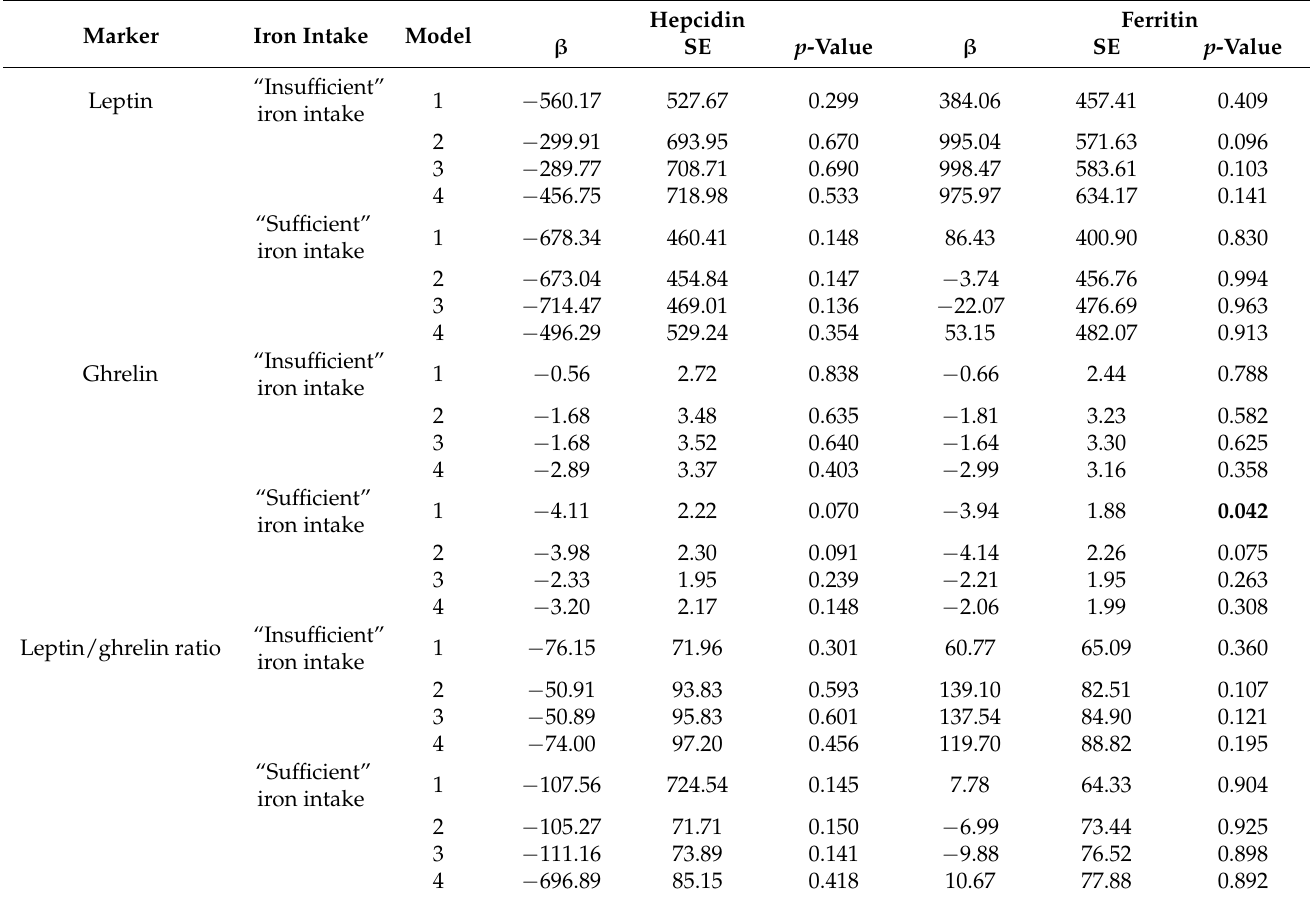
Table 3. Associations between hepcidin, ferritin, and markers of energy balance in the fasted state, stratified by dietary intake. Marker Iron